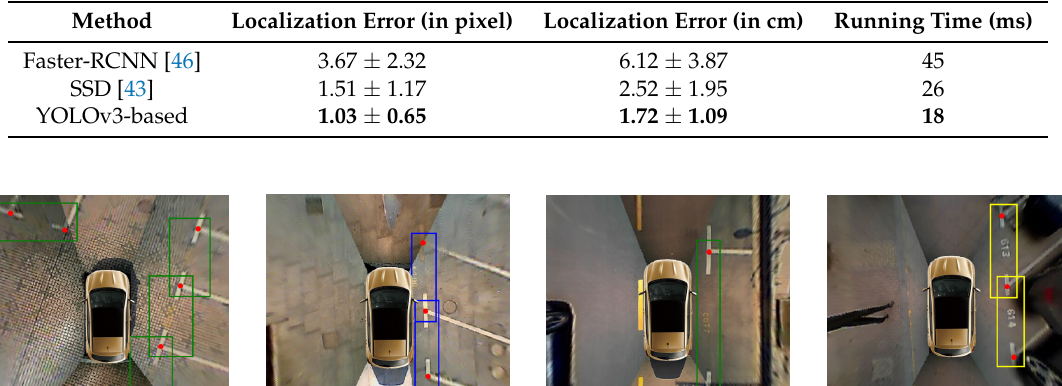
Figure 11. AP 50 histograms by three kinds of DCNN-based detectors. Table 3. Localization error of marking points and running time of three kinds of DCNN-based detector.